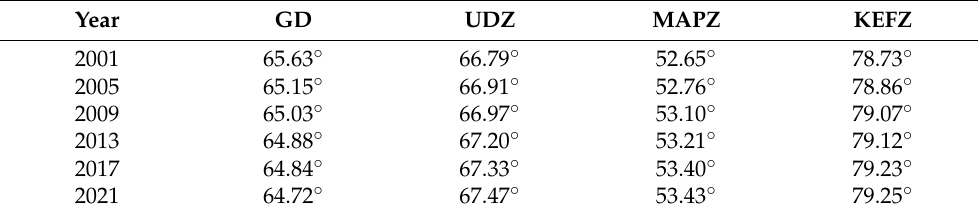
Table 5. Changes in the elliptical directional angle of carbon emissions standard deviations in Guangdong Province and its MFOZs from 2001 to 2021.